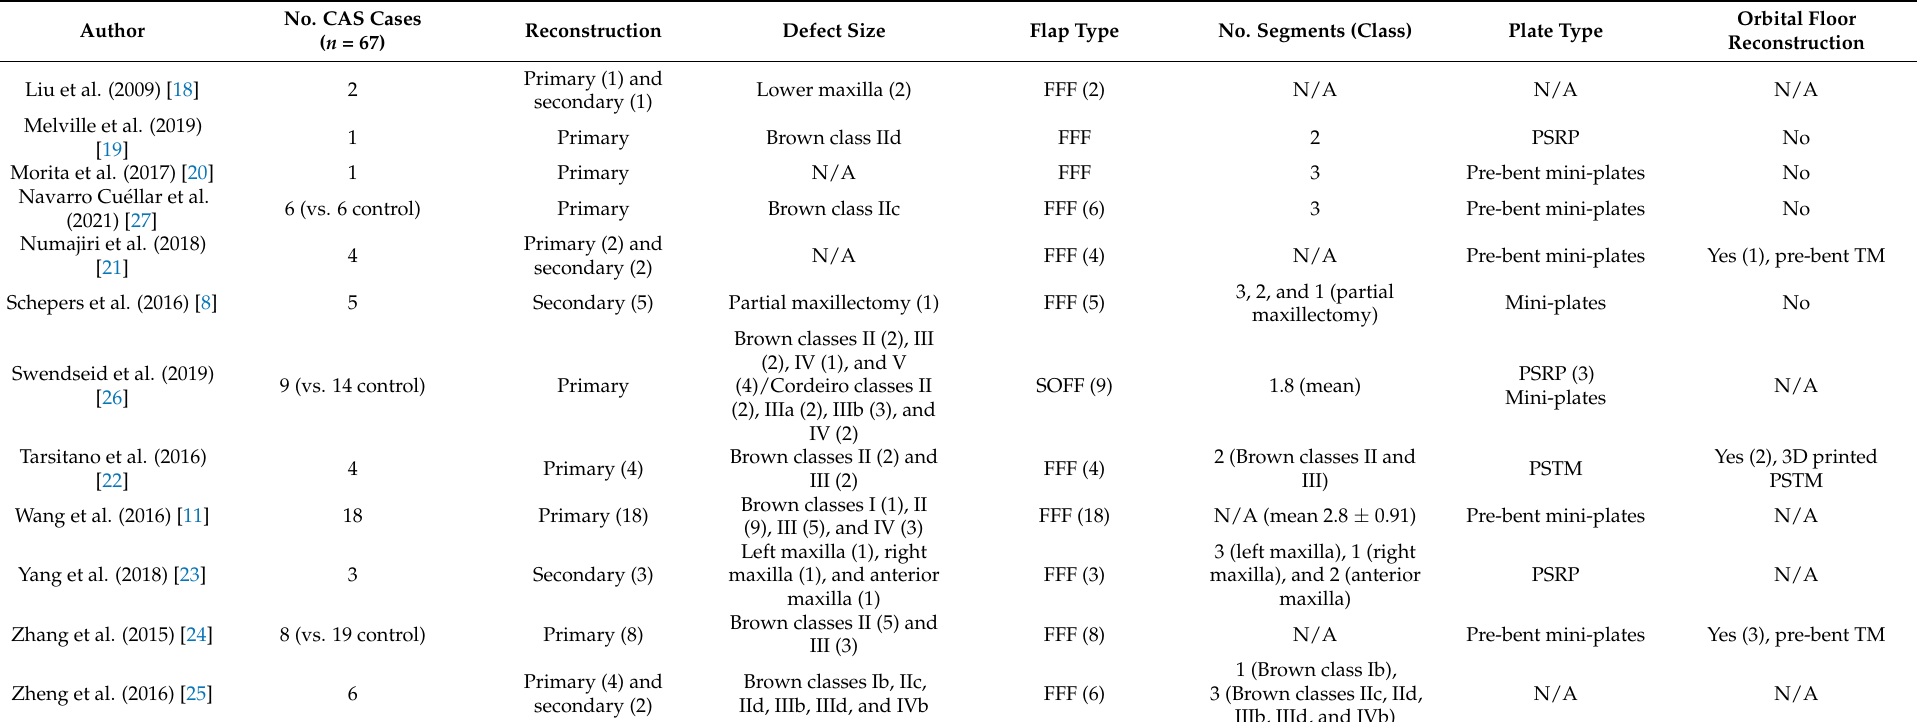
Table 1. Characteristics of the included